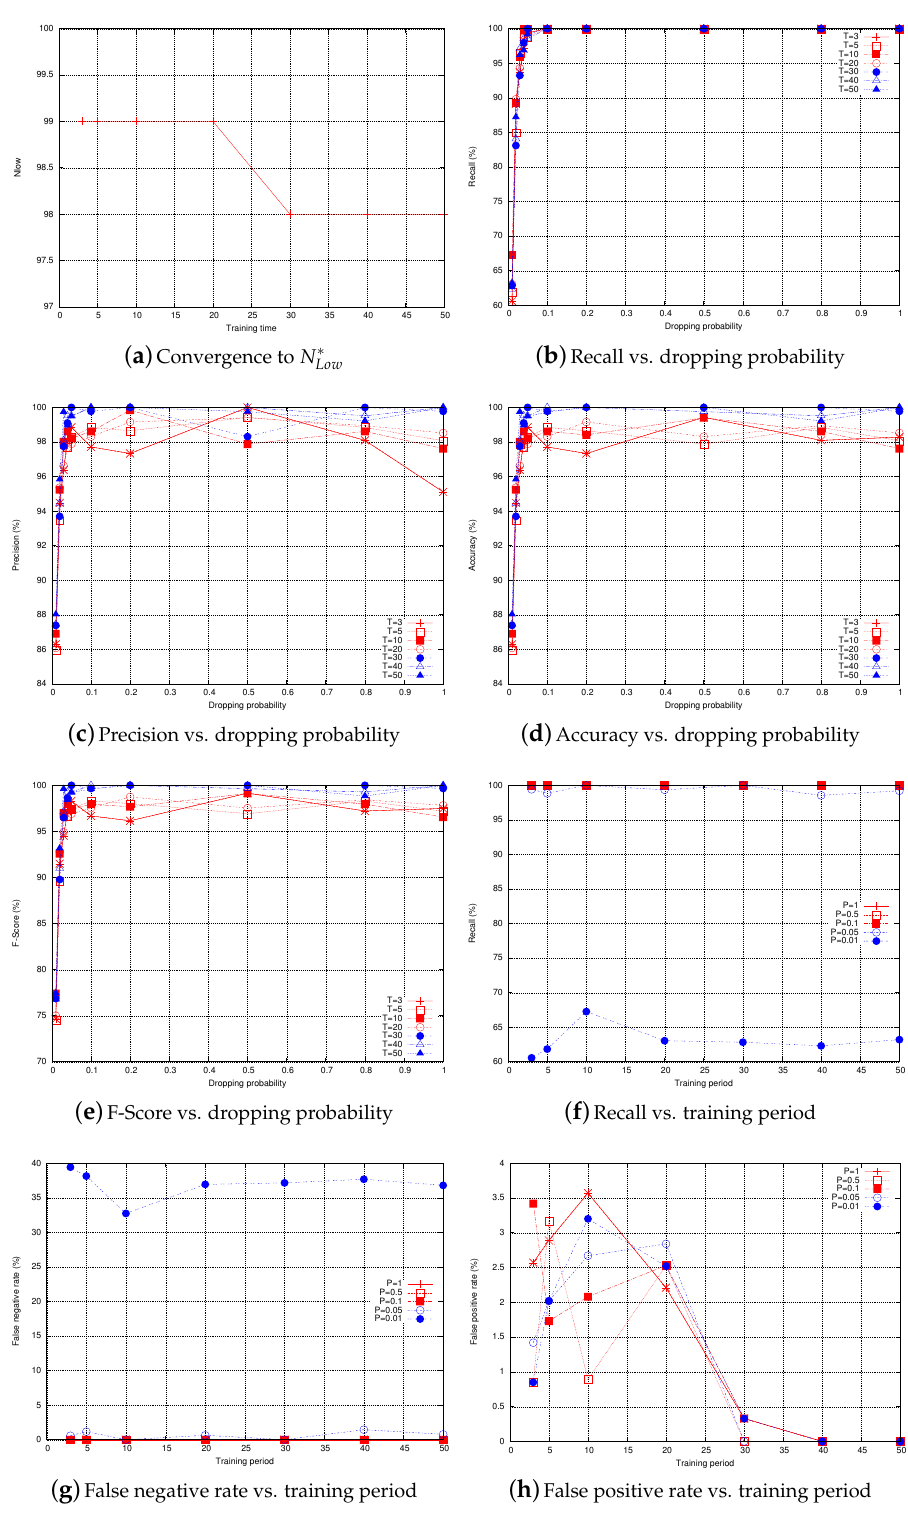
Figure 8. Performance of the proposed